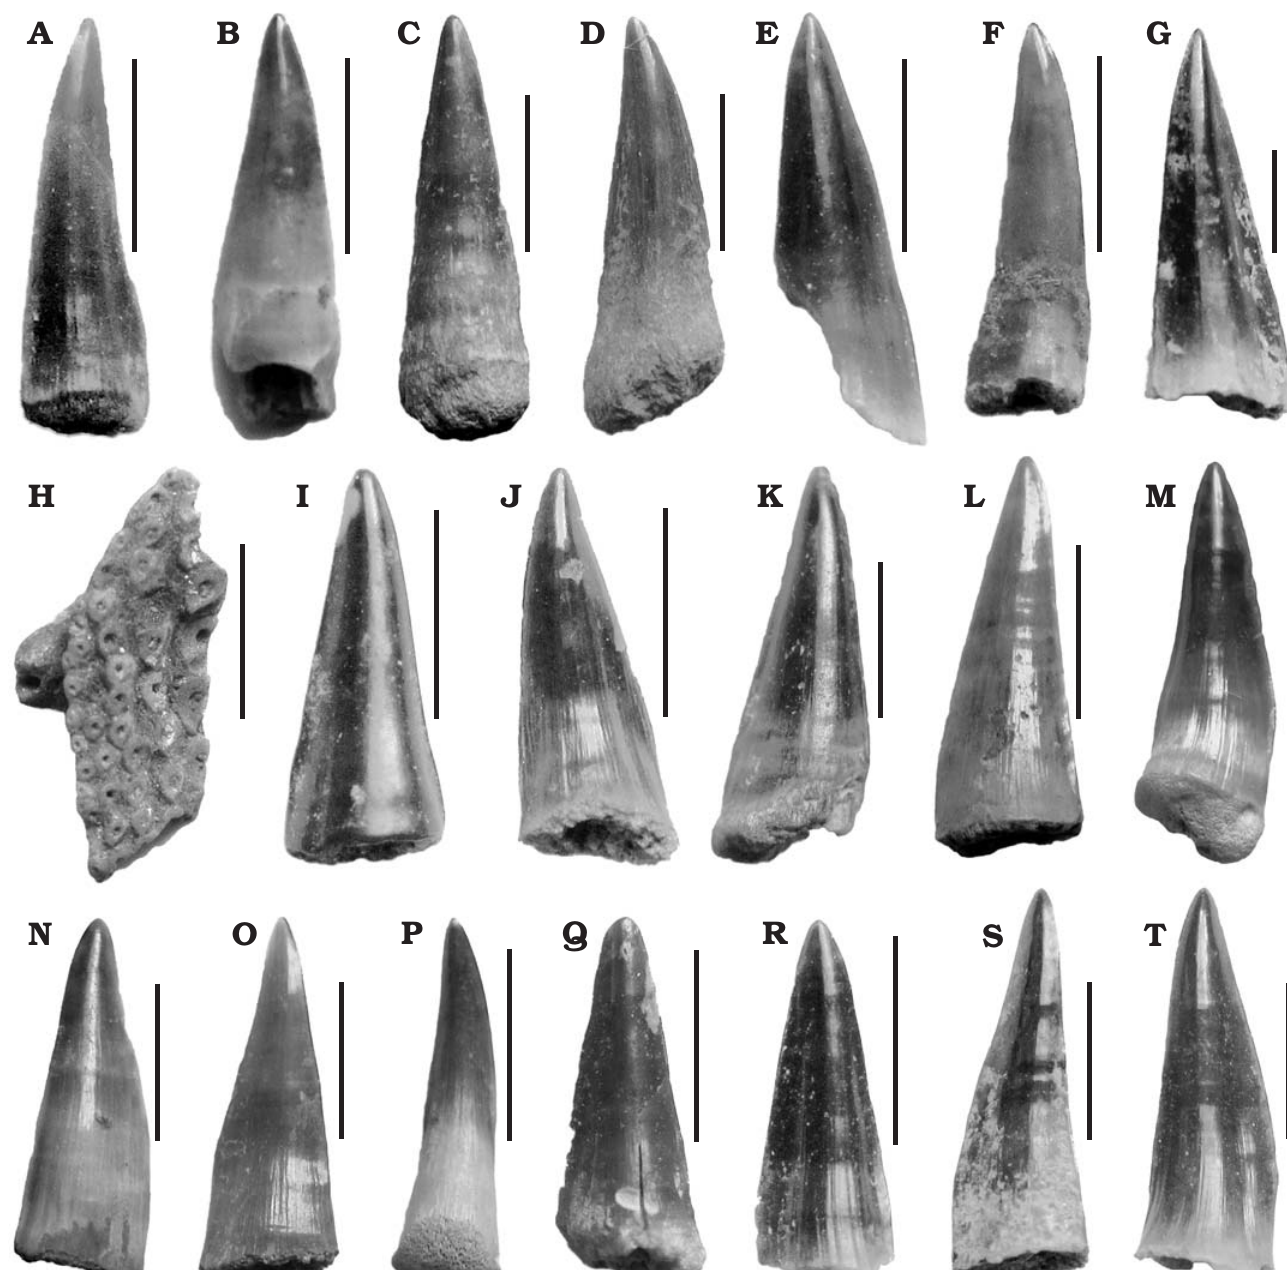
Fig. 6. Isolated elements assigned to a pike Esox spp. from Southeastern Europe; late Miocene (A–J), Pliocene (N–Q), and Pleistocene (K–M, R–T). A – G , I – T . Tooth, lateral view. A . NMNHU-P 41/3472, Palievo. B . NMNHU-P 33/561, Mykhailivka 2. C . NMNHU-P 29/1708, Popovo 3. D . NMNHU-P 29/1045, Verkhnya Krynitsya 2. E . NMNHU-P 41/4498, Egorovka 2. F . NMNHU-P 41/4329, Egorovka 1. G . NMNHU-P 38/1964, Novoukrainka 1. I . NMNHU-P 41/2466, Pontian Lectostratotype. J . NMNHU-P 41/2742, Vinogradovka 1. K . NMNHU-P 53/4395, Bol’shevik 2. L . NMNHU-P 29/380, Lysa Gora 1. M . NMNHU-P 53/4388, Semibalka 1. N . NMNHU-P 42/2458, Vinogradovka 2. O . NMNHU-P 53/4281, Obukhovka 2. P . NMNHU-P 53/4344, Zhevakhova Gora. Q . NMNHU-P 29/627, Verkhnya Krynitsya 1. R . NMNHU-P 42/2463, Kotlovina 2. S . NMNHU-P 53/4406, Medzhibozh. T . NMNHU-P 42/2472, Kotlovina 3. H . Left palatine (NMNHU-P 33/517), Andreevka, occlusal view. Scale bars: C, D, H–O, R, S, T, 5 mm; A, B, E, F, P, Q, 4 mm; G, 3